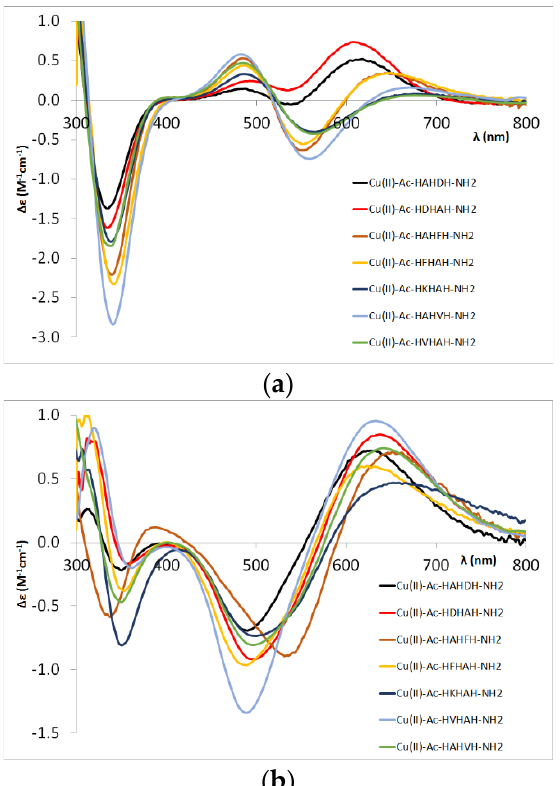
Figure 5. CD spectra of the [CuH − 2 L] ( a ) and [CuH − 3 L] ( b ) complexes of different pentapeptides